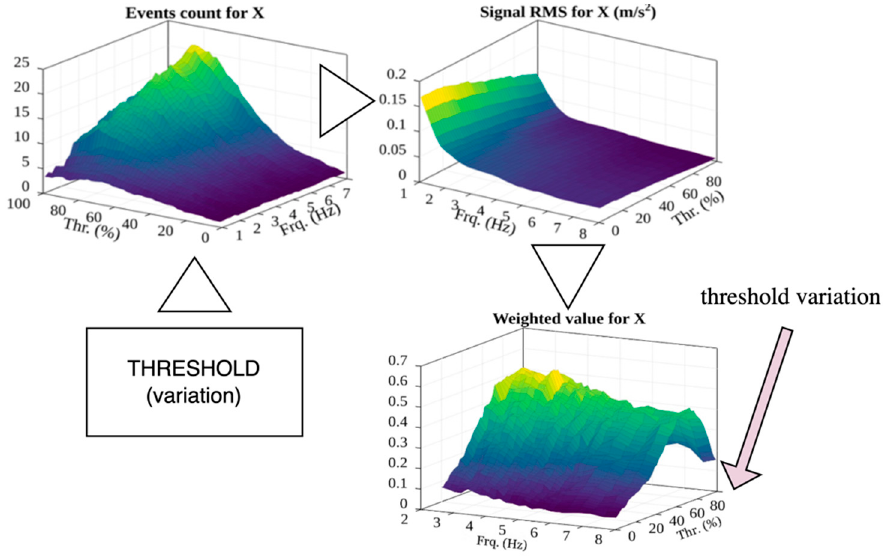
Figure 6. Threshold detection process deconstruction using the RMS and Weighted values parameters in the search.